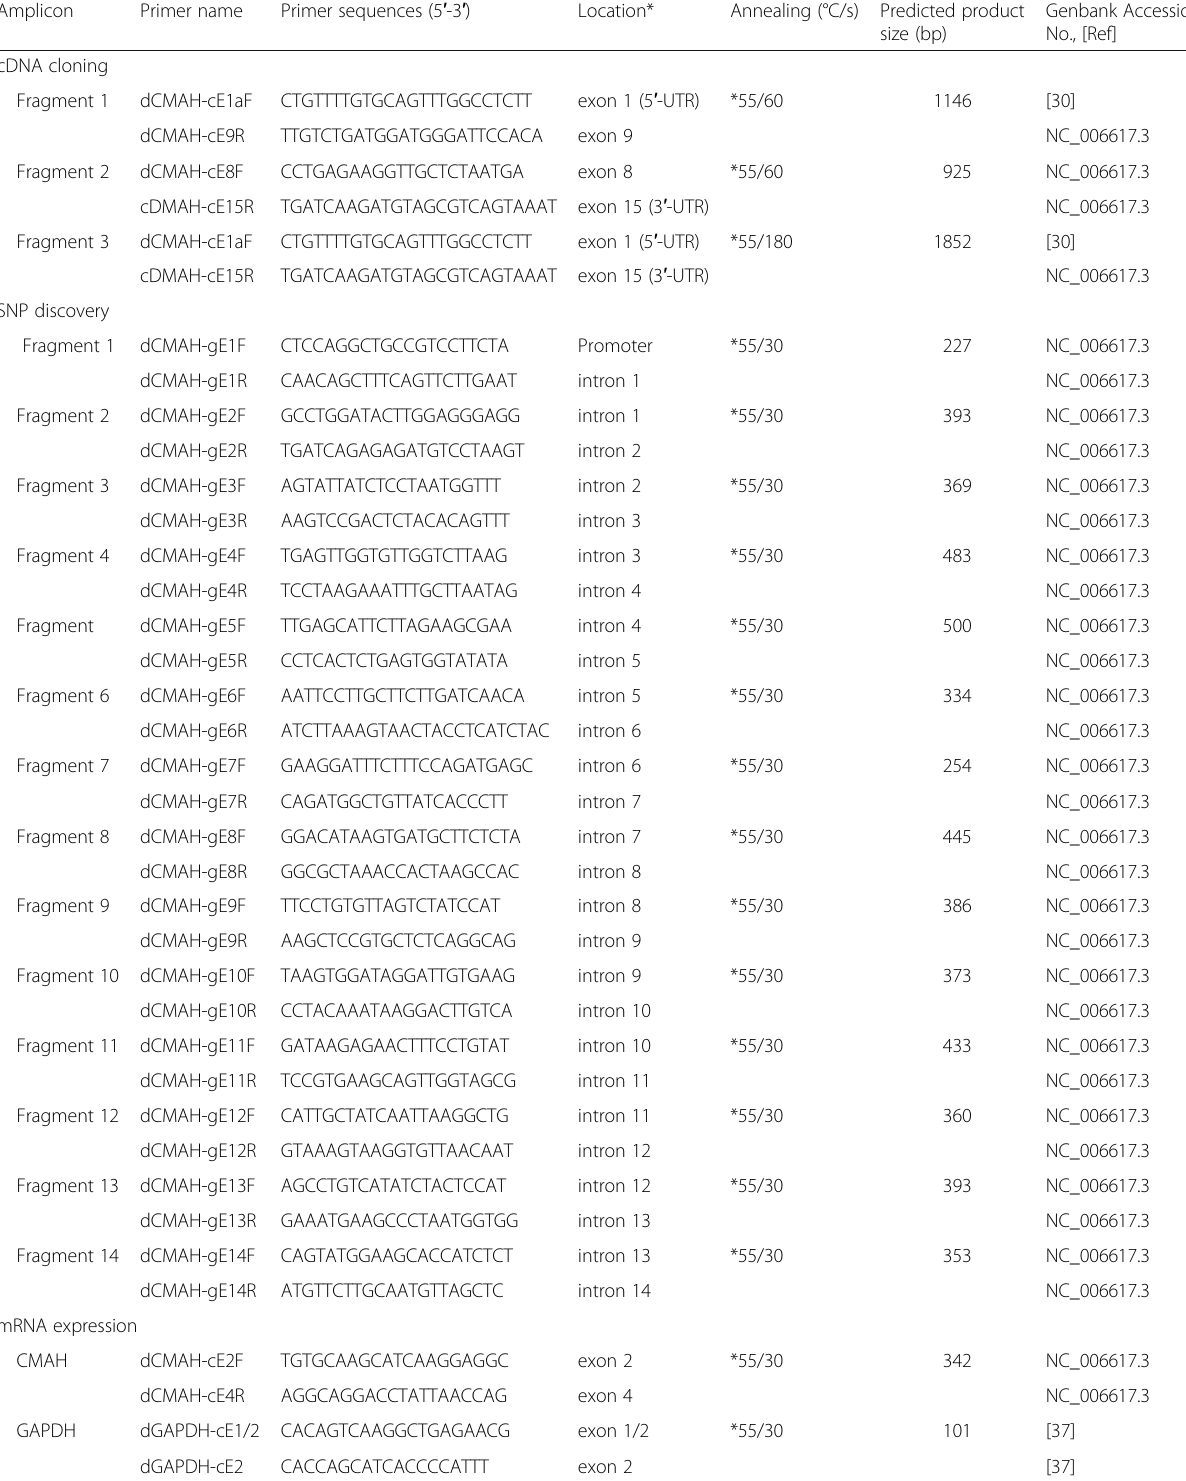
Table 3 List of primer used for analysis of the canine CMAH gene